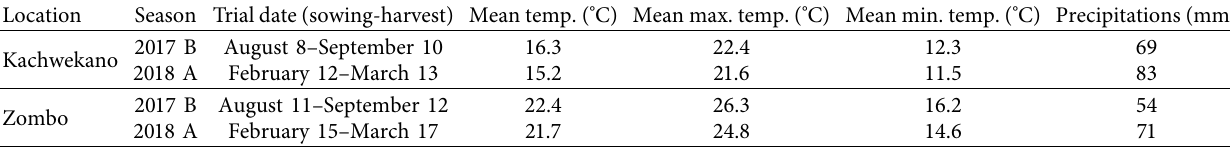
Table 1: Climatic conditions of the field experiments at two